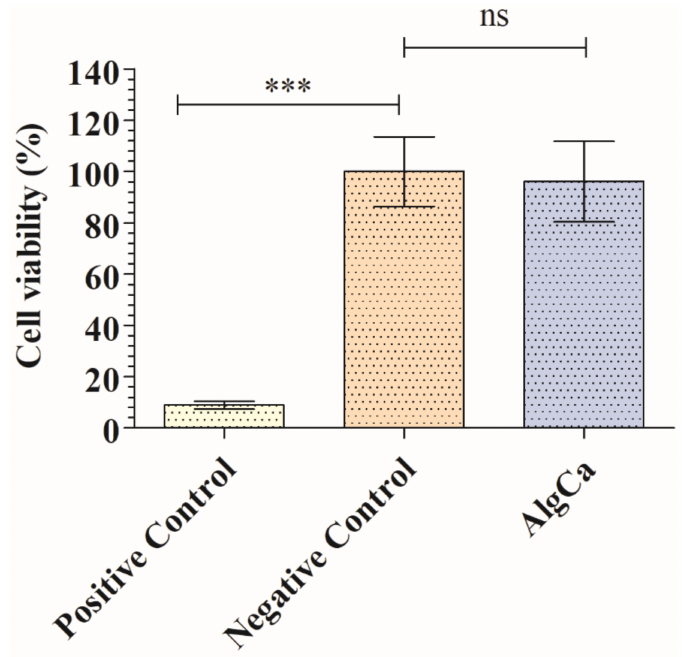
Figure 2. MTT cytotoxicity tests of extracts obtained from the calcium alginate films (AlgCa), negative control (culture medium used to produce the films extracts), and positive control (cytotoxic 1000 µ M zinc chloride solution) cultured in human keratinocyte HaCaT cells at 37 ◦ C. ANOVA with subsequent Tukey’s post hoc test: *** p > 0.001; ns, not